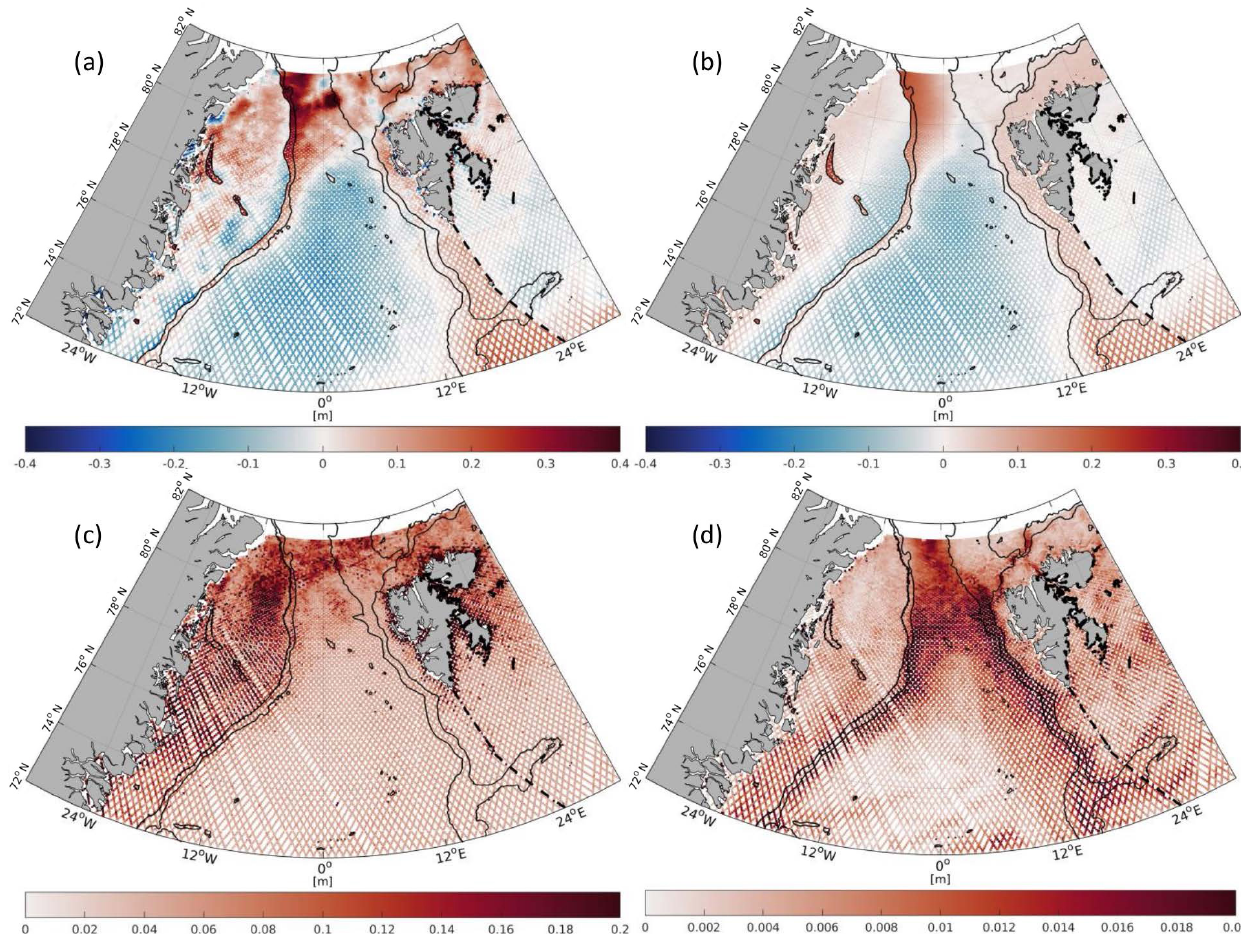
Figure 8. Weighted mean residual DOT (a, b) and weighted mean of standard deviation (c, f) for each bin from altimetry (a, c) and FESOM (b, d) within 2003–2009. Note the different scales of standard deviation color bars.